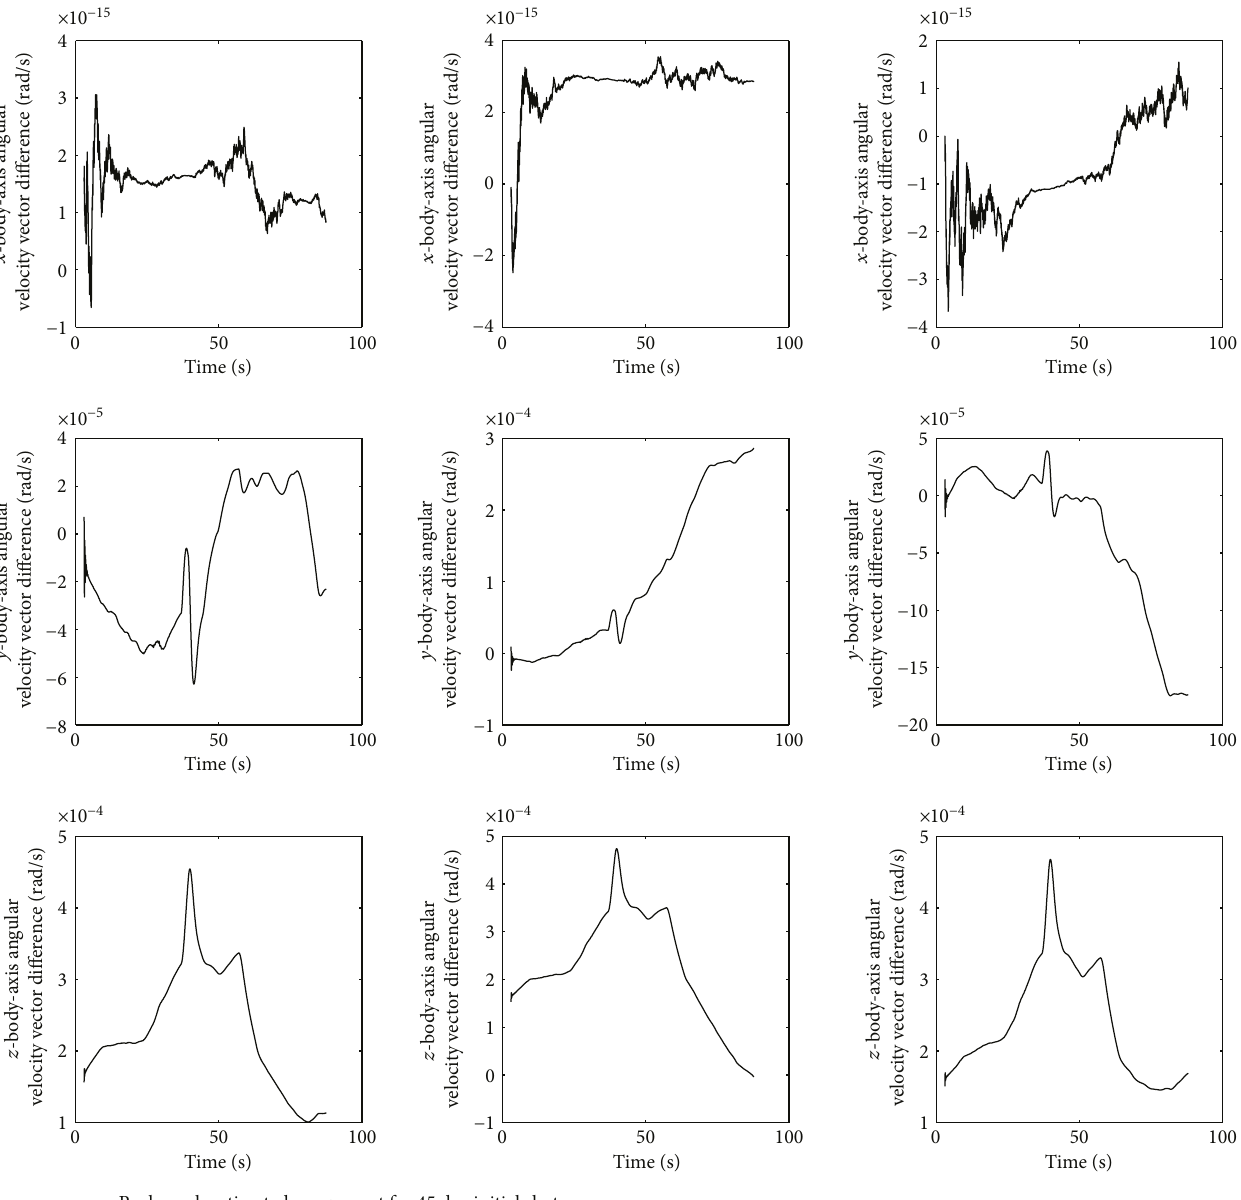
Figure 4: Comparison between estimated and real magnitudes for aircraft angular velocity for a shot angle of 45deg and azimuths of 0 ° (left), 45 ° (center), and 90 °